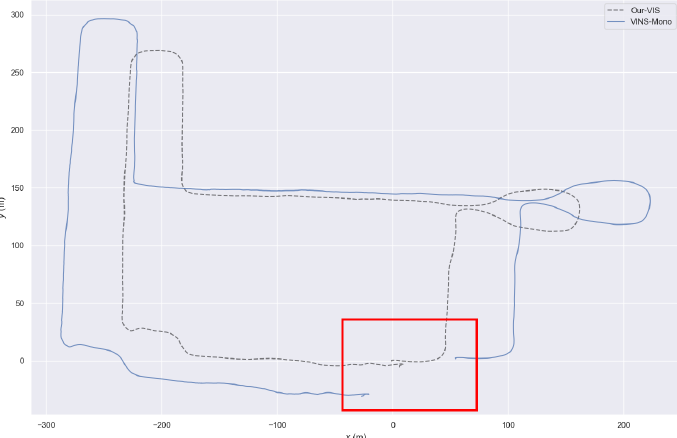
Figure 9. The result of our VIS and VINS-Mono on YQ-map dataset. It goes back to origin.